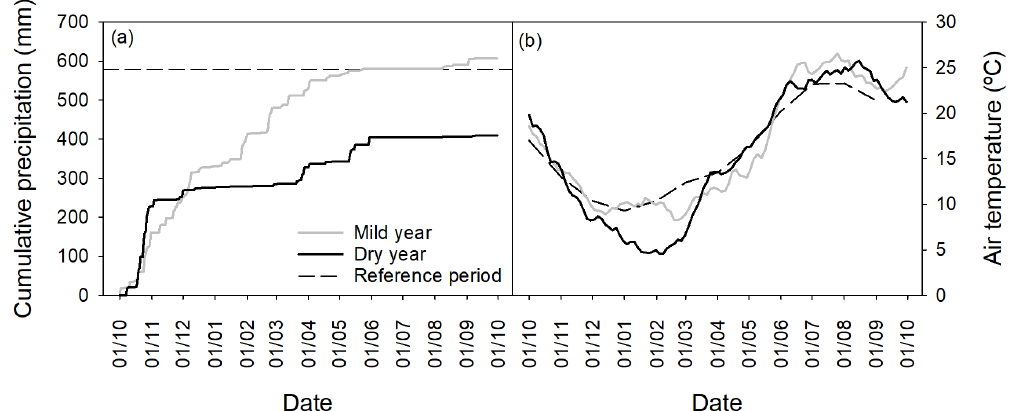
Figure 1. (a) Cumulative precipitation (mm) and (b) smoothed (7 days running average) daily mean temperature ( ◦ C) for the study period. The long-term precipitation and monthly mean temperatures are included as a reference.